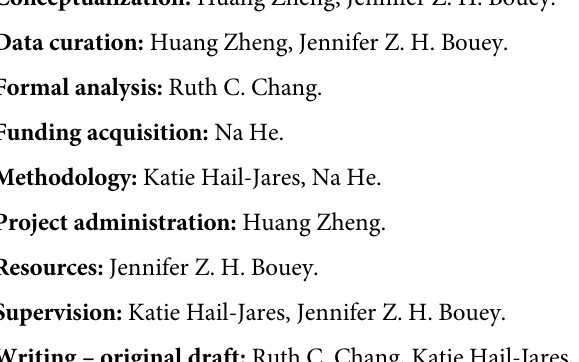
S1 Table. Edited dataset from the HIV survey of 248 street-based sex workers in Shanghai,